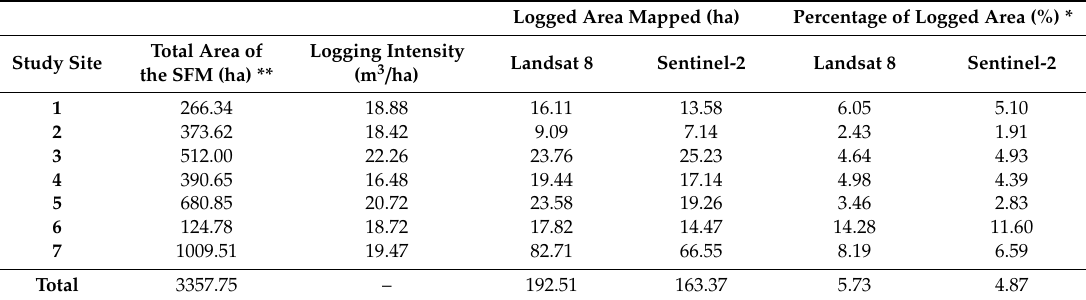
Table 4. Comparison of logging-a ff ected areas derived from Landsat 8 and Sentinel-2 imagery through the ∆ rNBR approach for our seven SFM test sites. Areas extracted from the maps are derived from pixel counting and were not